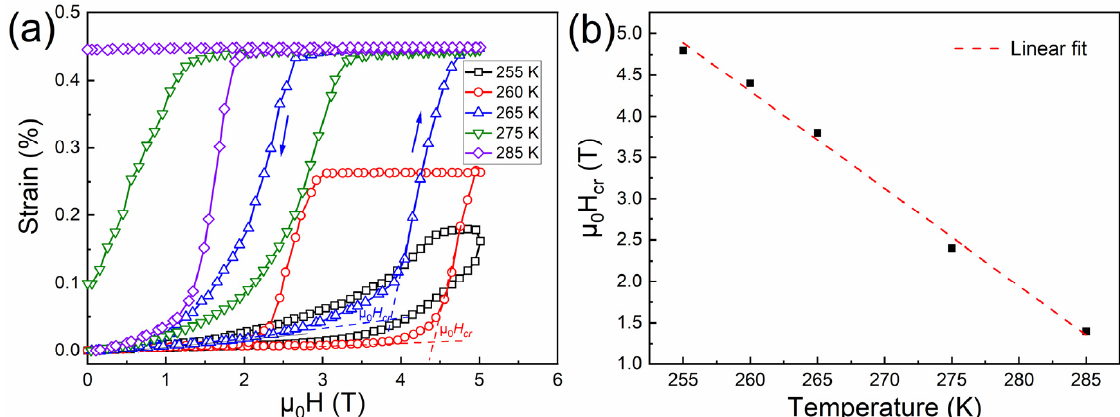
Figure 4. ( a ) Field dependence of strain for the directionally solidified Ni 44.5 Co 4.9 Mn 37.5 In 13.1 alloy measured at various temperatures when applying a magnetic field up to 5 T. ( b ) Temperature dependence of critical magnetic field ( μ 0 H cr ) to drive the reverse martensitic transformation.